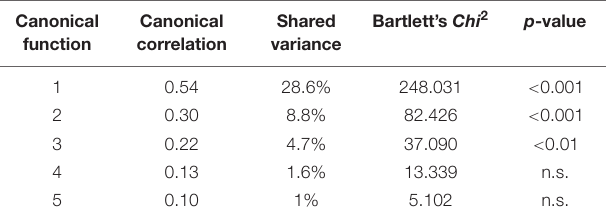
TABLE 4 | Canonical correlations with personality traits as predictors and internal dialogicality as criteria. Canonical function